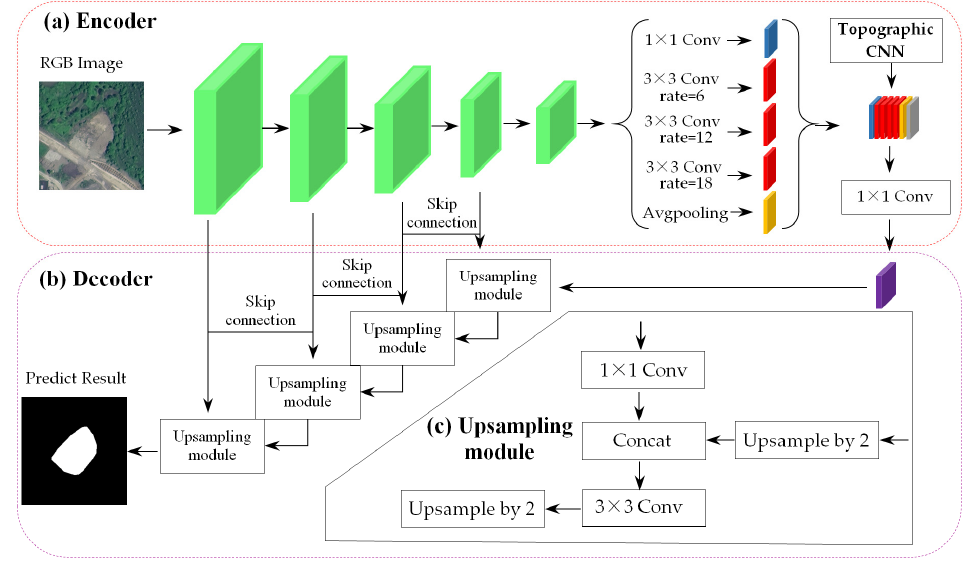
Figure 3. Architecture of the improved DeepLabv3+. ( a ) Encoder for landslide feature extraction; ( b ) Decoder for concatenating low- and high-level featues; ( c ) Upsampling module.